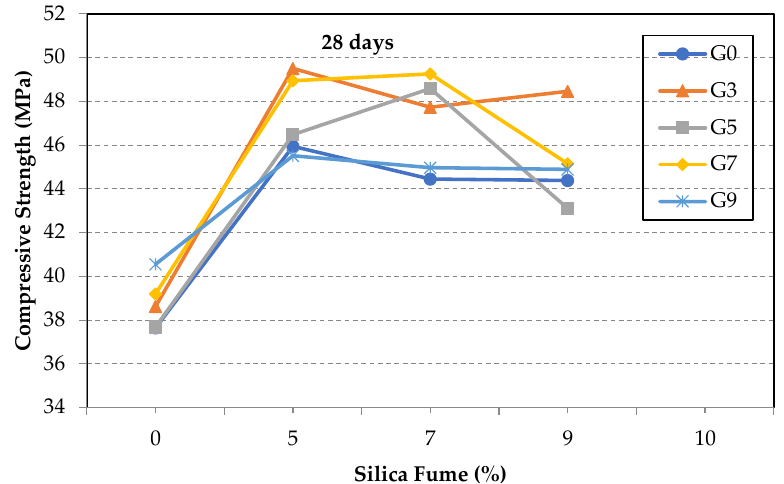
Figure 5. Compressive strength of test specimens at seven days.